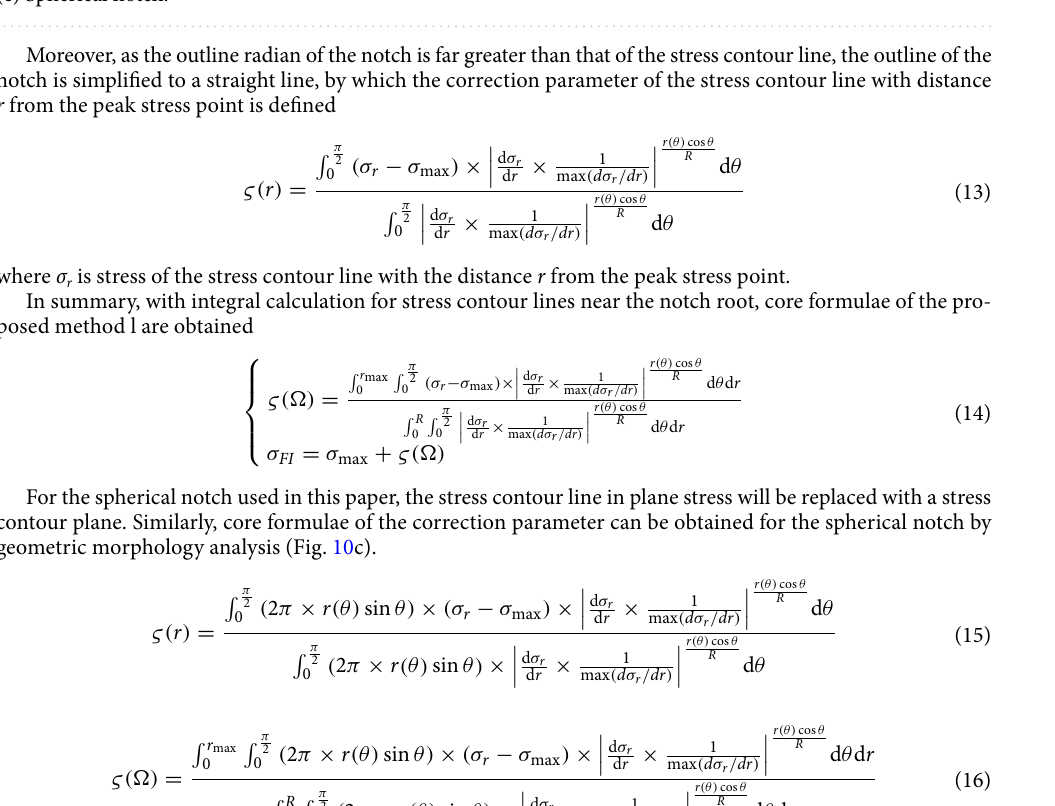
Figure 10. Simplifications of stress contour line near notch root: ( a , b ) Regular circular notch in plane stress; ( c ) Spherical